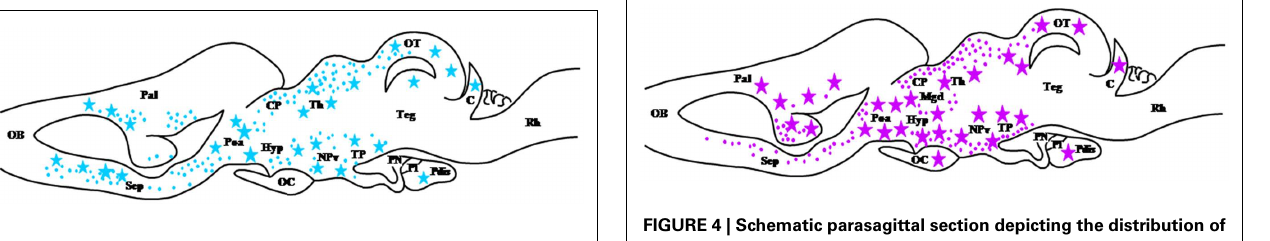
FIGURE 3 | Schematic parasagittal section depicting the distribution of cytochrome P450 C17 (P450 C17 )-immunoreactive cell bodies (stars) and fibers (dots) in the central nervous system of Rana esculenta (Do Rego et al., 2007). For other designations, see Figure 2 .